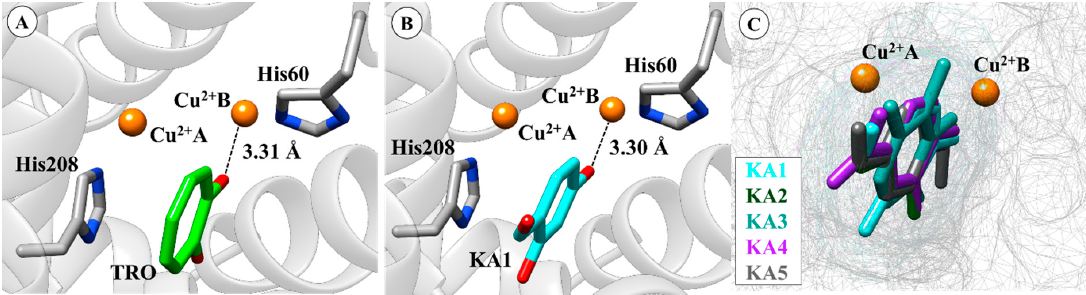
Figure 5. ( A ) Anchoring mode tropolone (TRO) on the active site of tyrosinase (TYR). ( B ) Anchoring mode KA1 on the active site of TYR. ( C ) Overlapping KA1, KA2, KA3, KA4 and KA5 on the active site. Docking distances are reported in ångström (Å). The 3D structures of the molecular docking results are available in Protein Data Bank (PDB) format in the Supplementary Materials (see Figure S2).